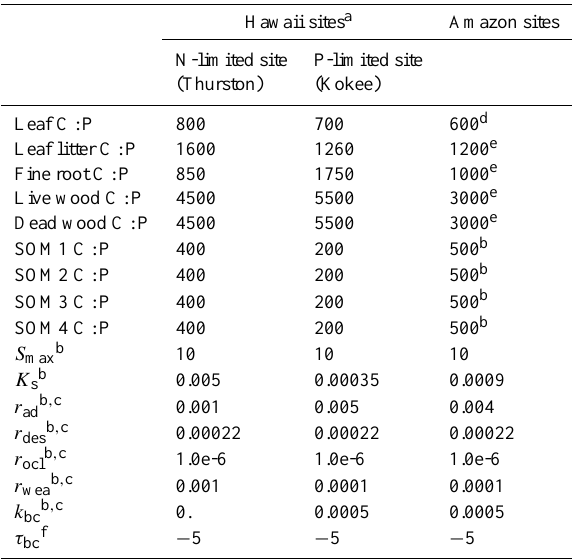
Table 3. Parameters of the P model used in this